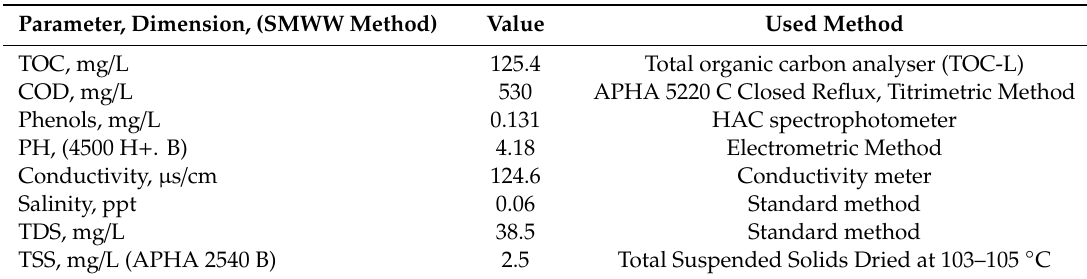
Table 2. Analysis results of F-T process waste water.